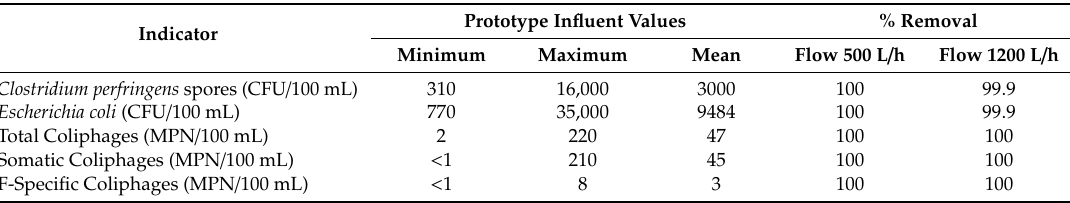
Table 5. Monitoring of microbiological indicators in the prototype at two workflows (500 and 1200 L / h) during a period of one year ( n = 40).